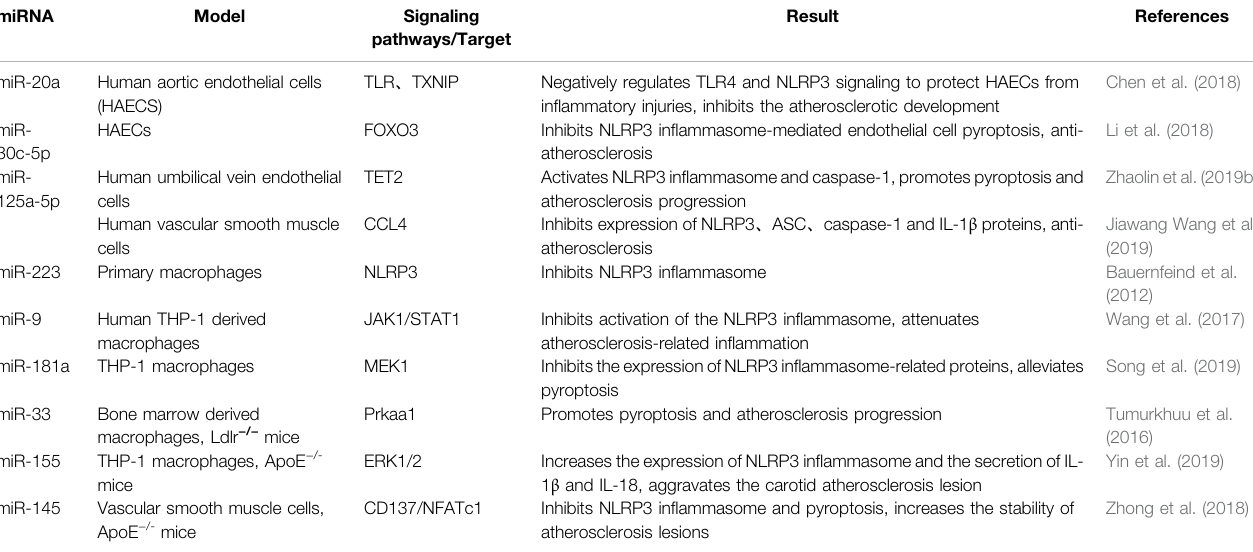
TABLE 1 | miRNA involved in the regulation of pyroptosis-related molecules. miRNA